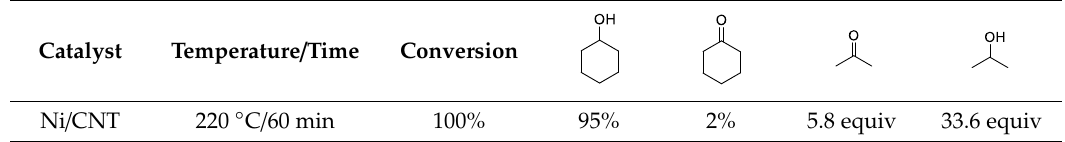
Figure 5. Time course of the yield of cyclohexanol carried out in the transfer hydrogenation ( a ). Time course of the yield of cyclohexanone carried out in the transfer hydrogenation ( b ). Table 5. Distribution of products with 20% Ni / CNT in isopropanol.